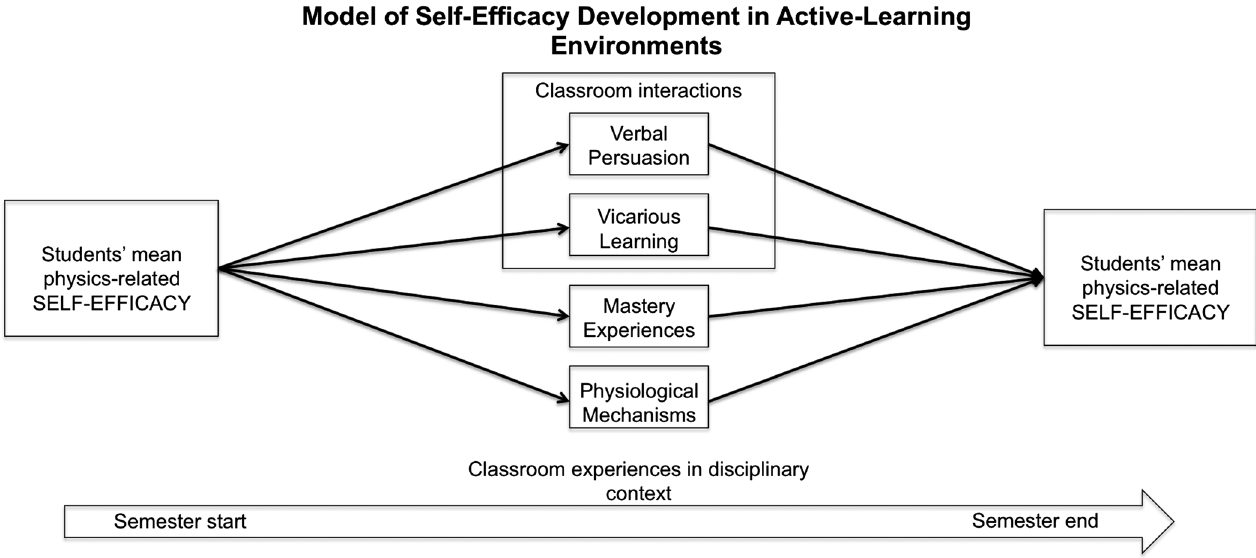
FIG. 1. Our model of self-efficacy development in active learning environments accounts for students ’ initial self-efficacy and its subsequent development as a result of classroom experiences. In alignment with theory, some of the development arises from learning experiences not directly related to social interaction (i.e., mastery experiences) [27]. In addition, we postulate that the social nature of many active learning environments has the capability of generating opportunities for students to receive verbal feedback or perceive others with whom they relate as successful or unsuccessful on physics tasks (i.e., verbal persuasion and vicarious learning experiences). Thus, we posit a link between certain types of classroom interactions and self-efficacy